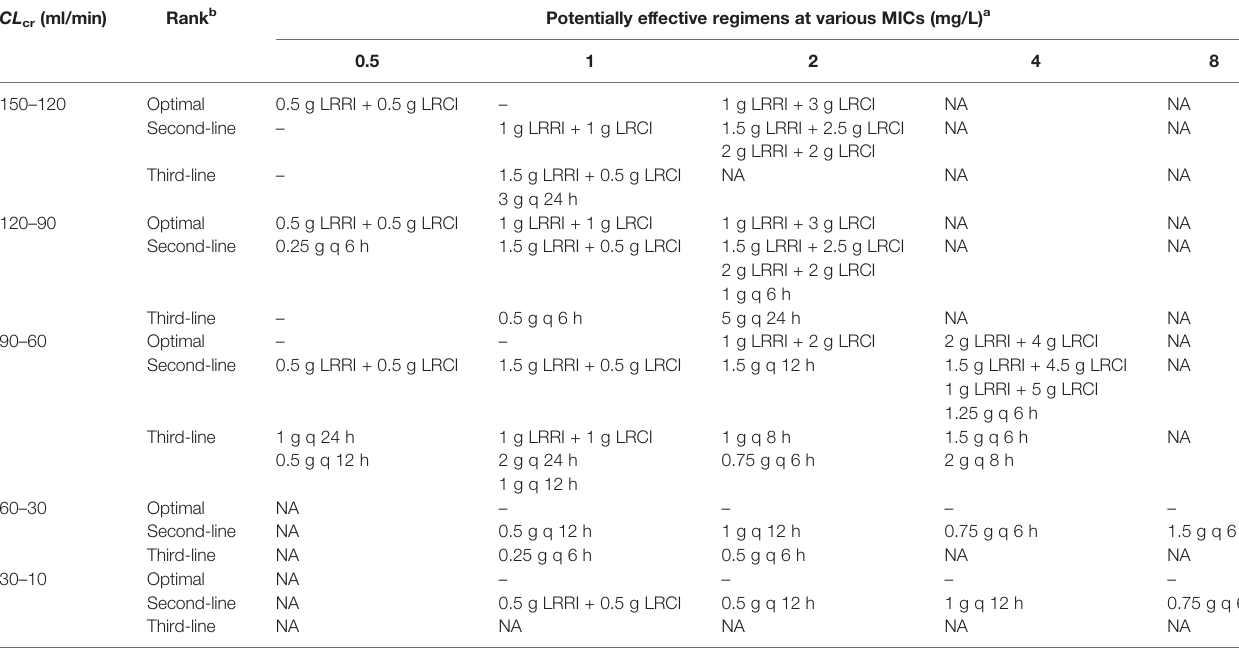
TABLE 2 | The optimal or inferior vancomycin regimens that the present study considered may be effective for the treatment of MRSA bloodstream infections occurring in critically ill patients, at different CL cr and MICs. Rank b Potentially effective regimens at various MICs (mg/L)